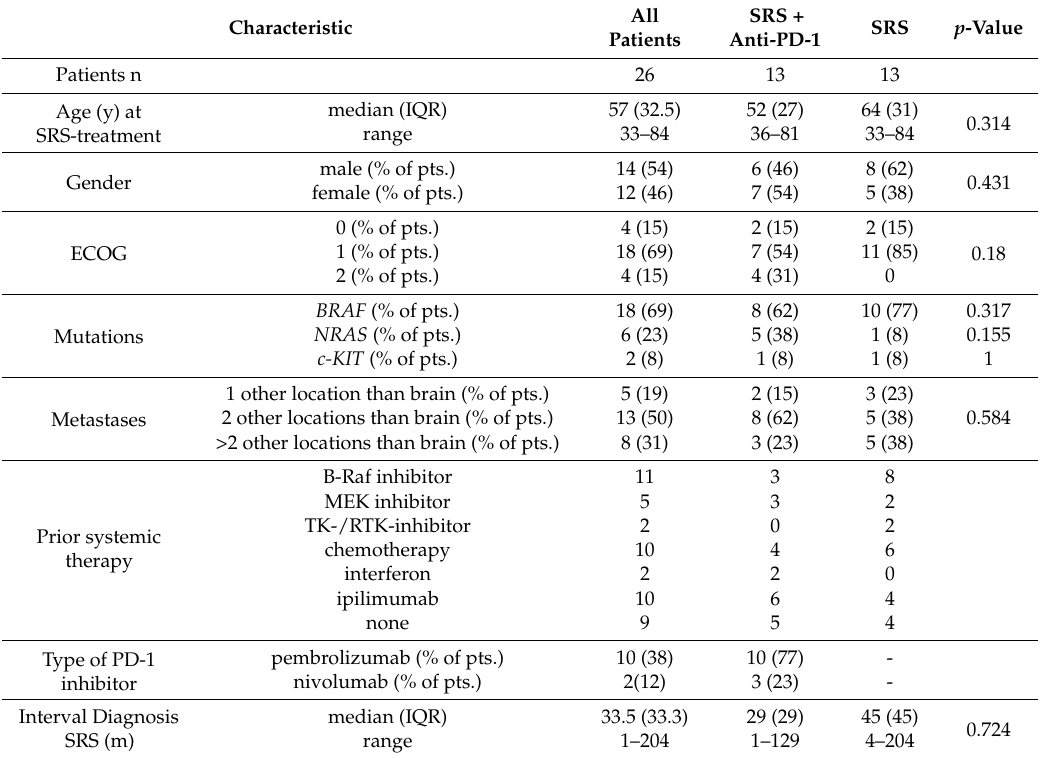
Table 1. Baseline